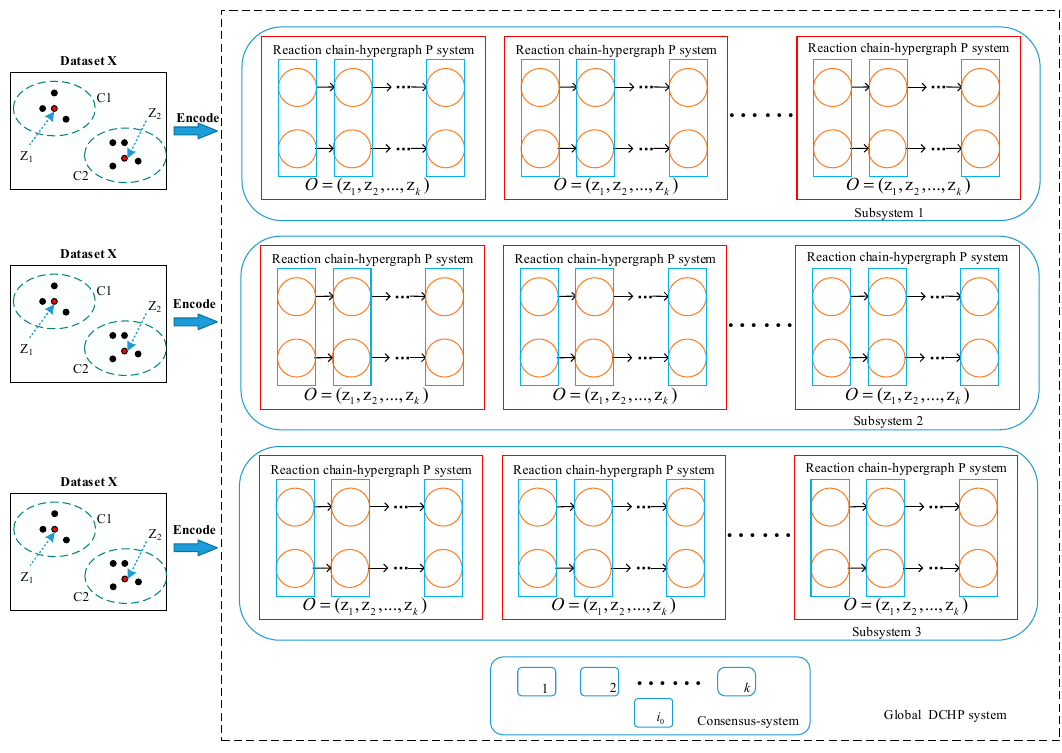
Figure 6 . The membrane structure of the DCHP system Figure 6. The membrane structure of the DCHP